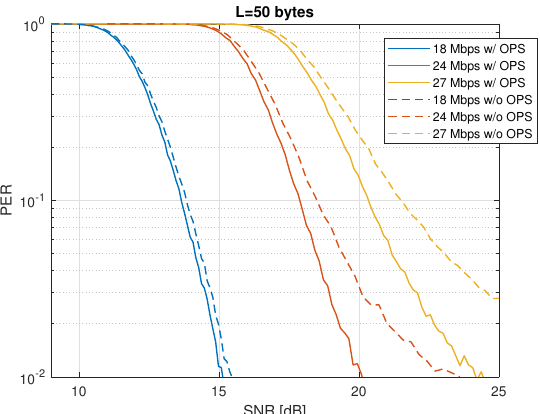
Figure 4. PER vs. SNR with non − linear HPA (IBO = 6 dB) with and without OPS technique for PAPR reduction ( L = 50